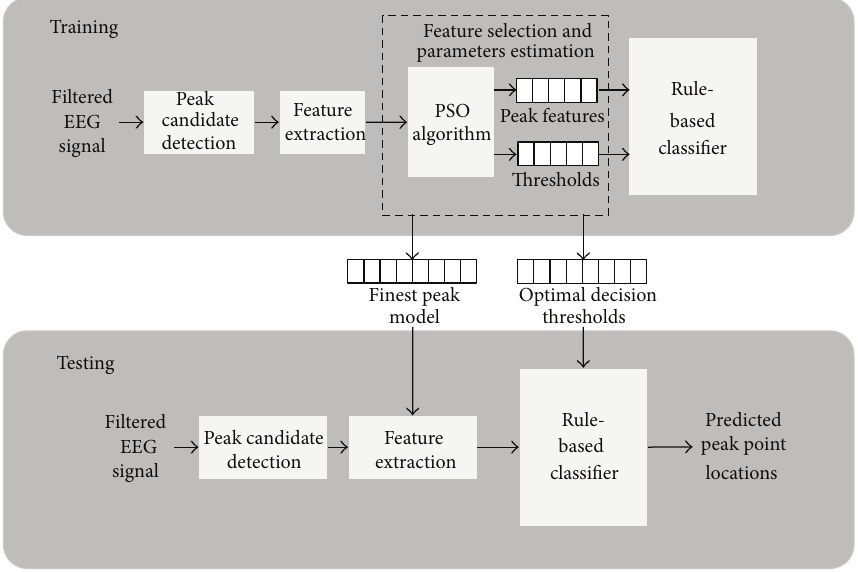
Figure 1: Feature selection and parameters estimation framework for peak detection algorithm.